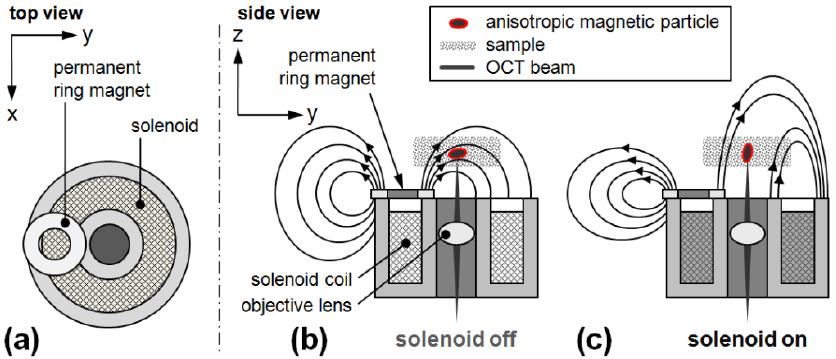
Figure 2. Principle of rotational magnetomotive OCT (rMM-OCT) using an electromagnet (solenoid) and a laterally displaced permanent magnet. ( a ) Top view and ( b , c ) side view of the dual-magnet configuration. When the solenoid is turned off ( b ), anisotropic magnetic particles in a soft sample are aligned horizontally ( y -direction) towards the field of the permanent magnet; when the solenoid is turned on ( c ), particles are aligned vertically ( z -direction) towards the field of the solenoid. Drawn magnetic field lines are a guide to the eye only. The indicated coordinate system ( x , y , z ) is identical to Figure 1b. The coordinate origin is at the optical axis of the OCT probe ( x = y = 0) and the surface of the solenoid ( z = 0) (color online).